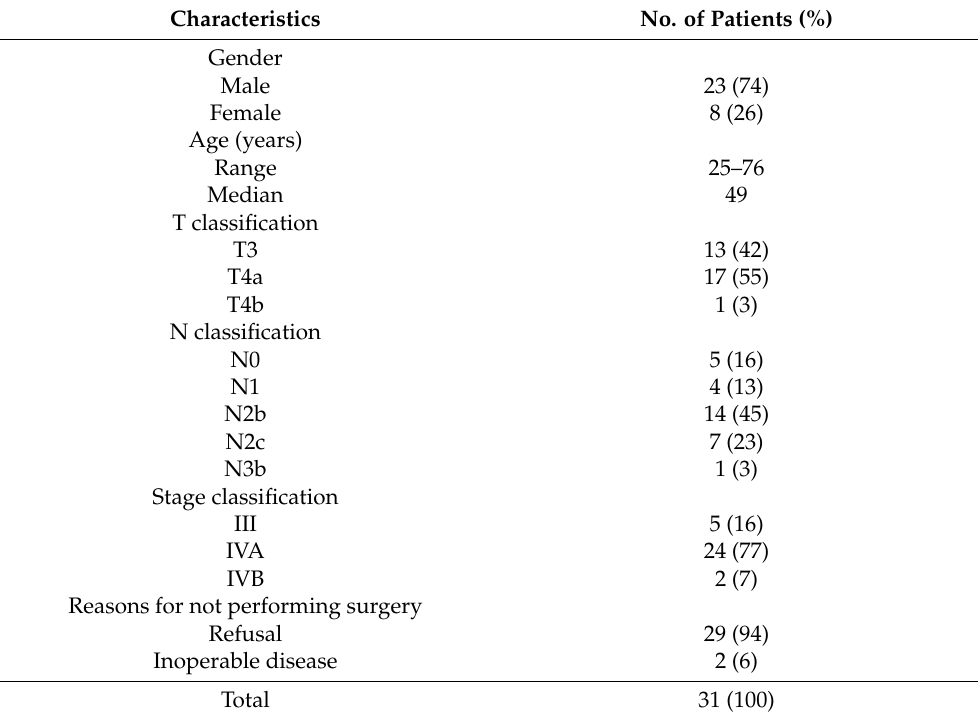
Table 1. Patient